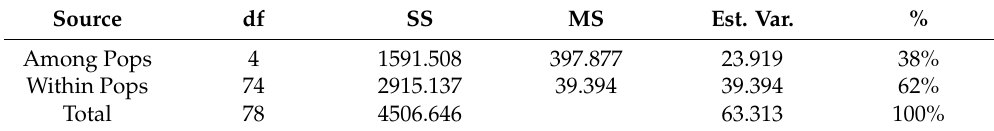
Table 2. Summary of analysis of molecular variance